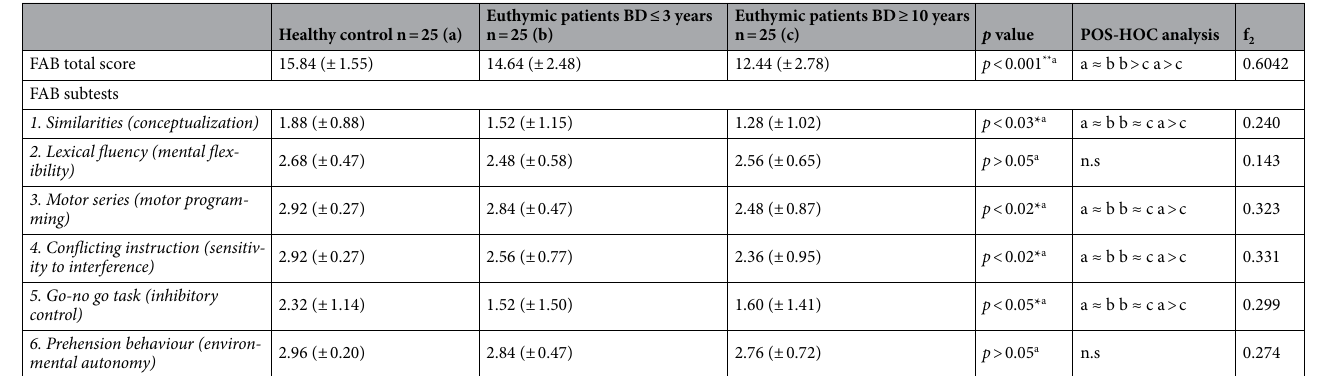
Table 6. Results of FAB subtests in Euthymic Patients with ≤ 3 years and ≥ 10 years of the disease. Means ± standard deviation (SD). FAB = Frontal Assessment Battery. n.s. = no significant a Kruskal–Wallis followed by Dunn´s post hoc to FAB test. [*] indicate FAB scores significantly different between groups. * p < 0.05 ** p < 0.001. f 2 = the overall Cohen’s effect size. This image was obtained with permission (IJAERS). Image origin: Cyrino et al., (2021). Assessment of different domain impairments in Cognitive Functions and Functionalities found in Euthymic Patients with Bipolar Disorder I / II - during the early and late phases of the disease, using the FAB and FAST tests. International Journal of Advanced Engineering Research and Science (IJAERS). 8,